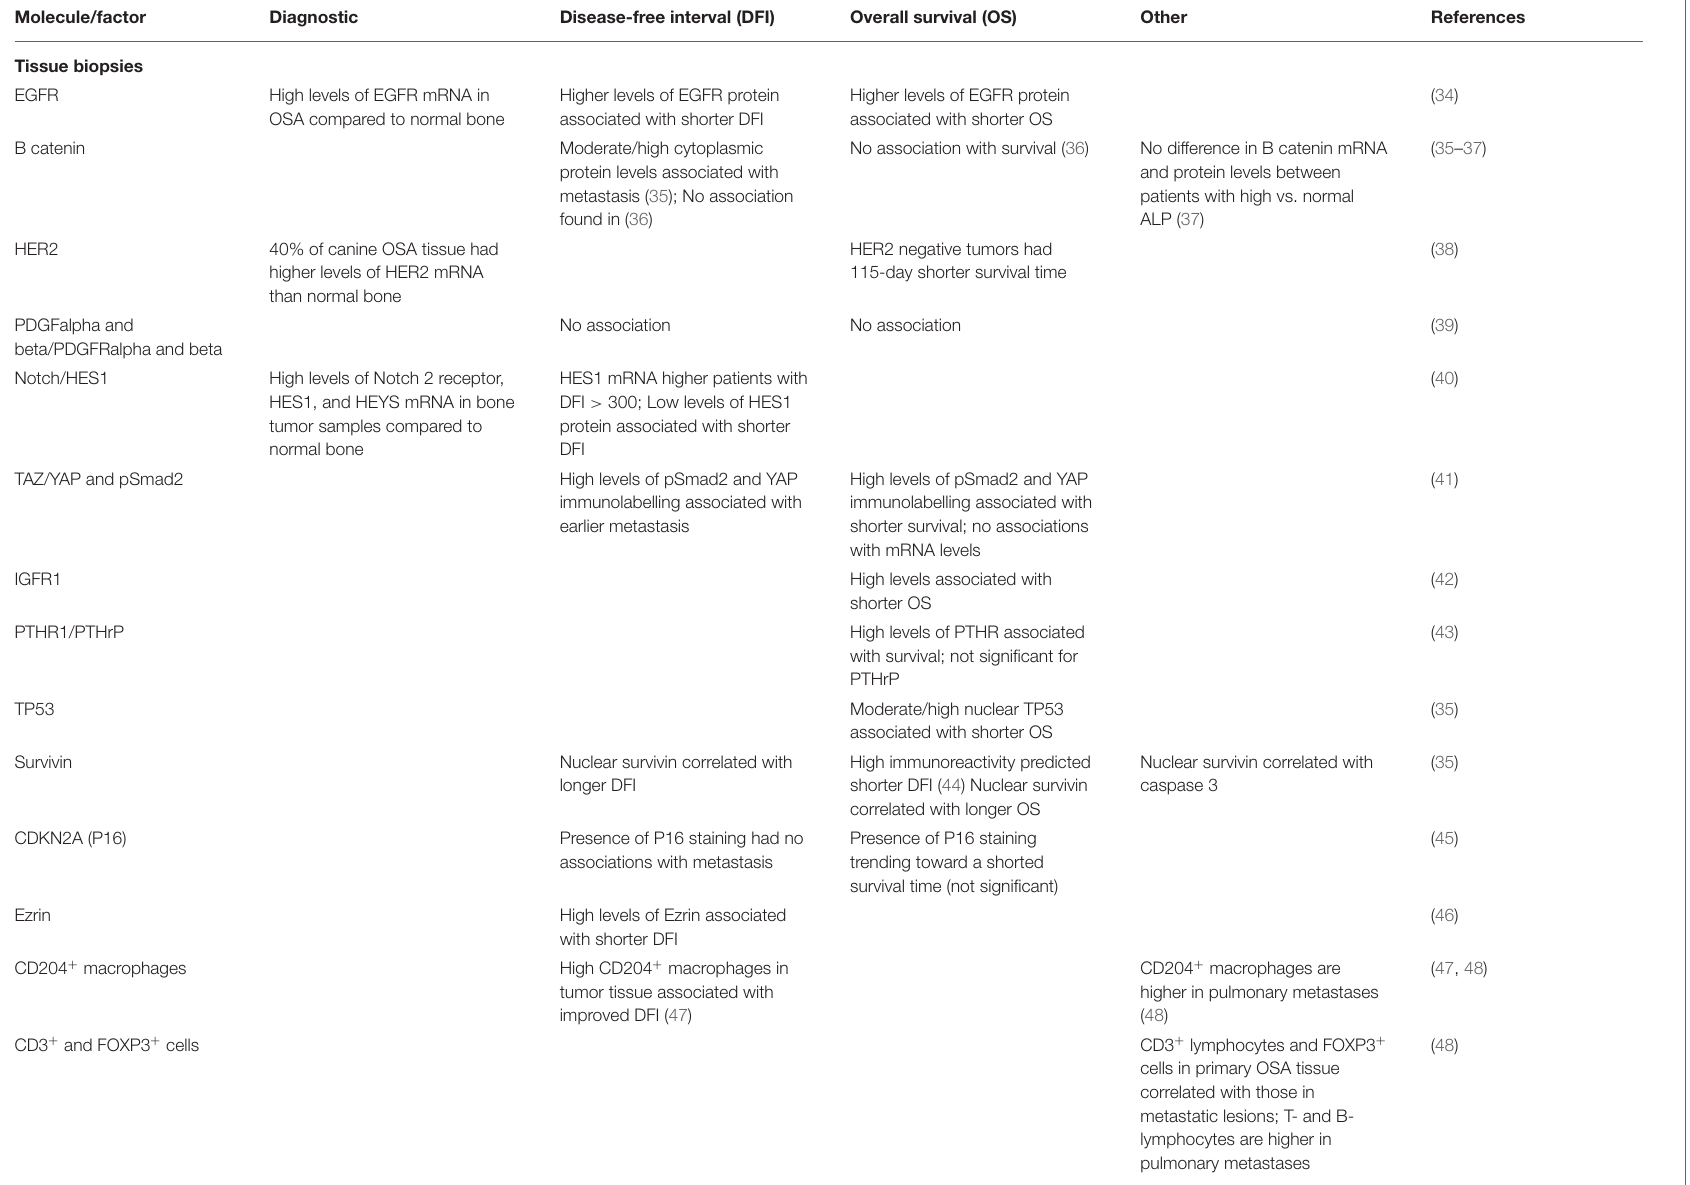
TABLE 1 | Summary of biomarkers explored in canine appendicular OSA using tissue and blood-based (liquid) biopsies.